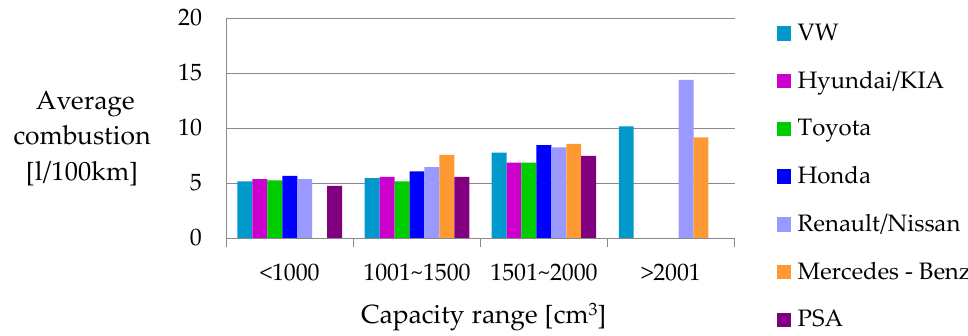
Figure 4. Average fuel consumption per engine capacity compartment; European and Asian car brands. Source: Developed own.